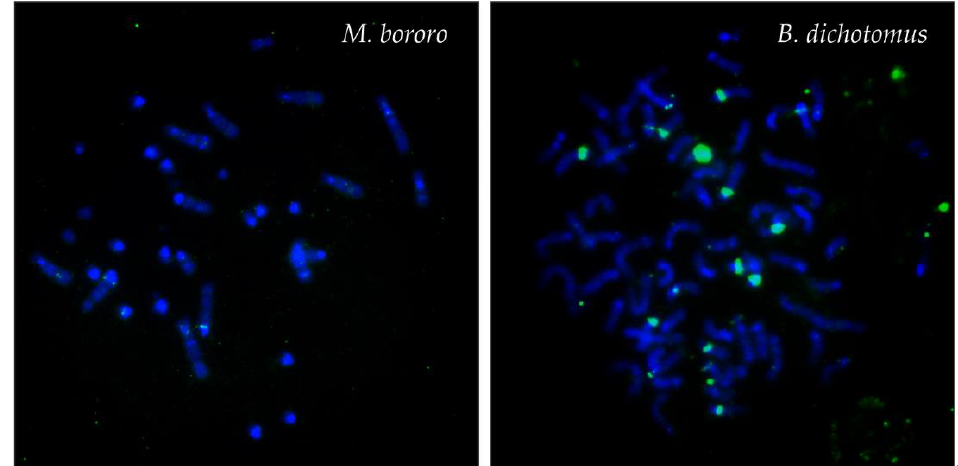
Figure 3. Examples of FISH patterns of the satIII (green) DNA probe in selected species. FISH pattern similar to the results in M. bororo was observed in all species except B. dichotomus .